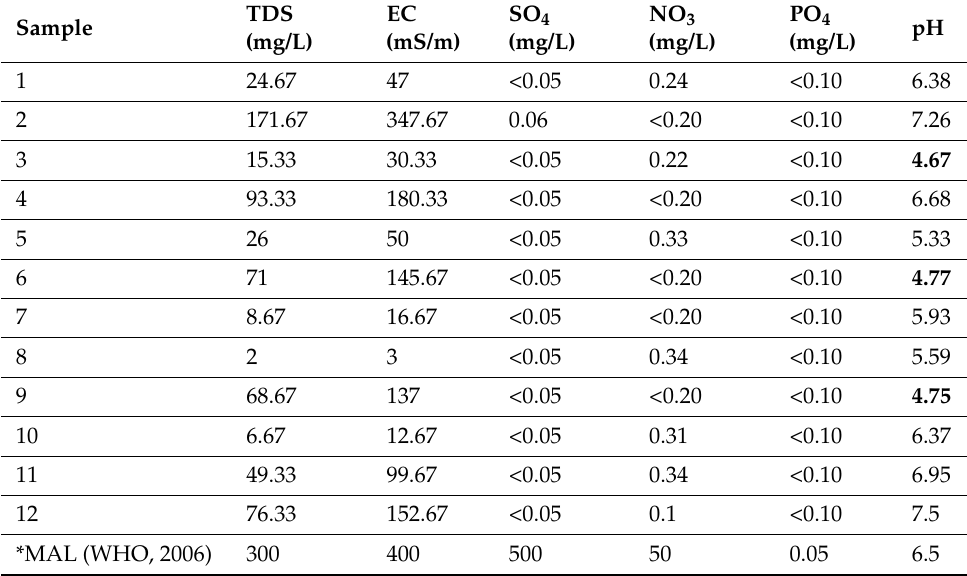
Table 1. Physicochemical properties of studied bottled water